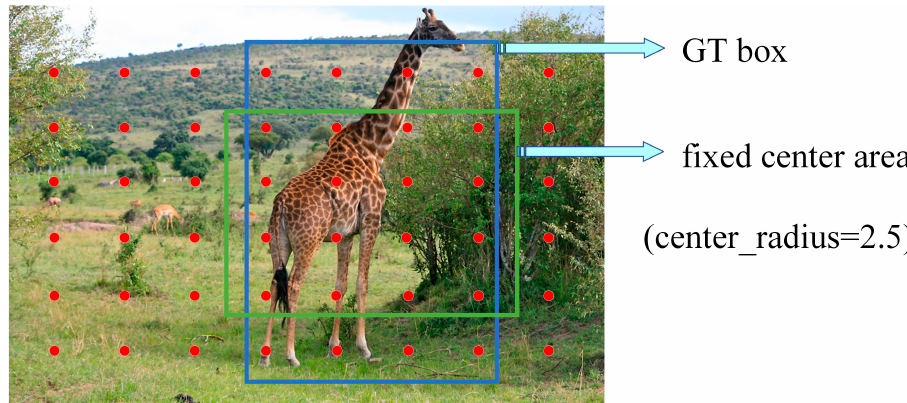
Figure 9. Example diagram of SimOTA pre-screening.